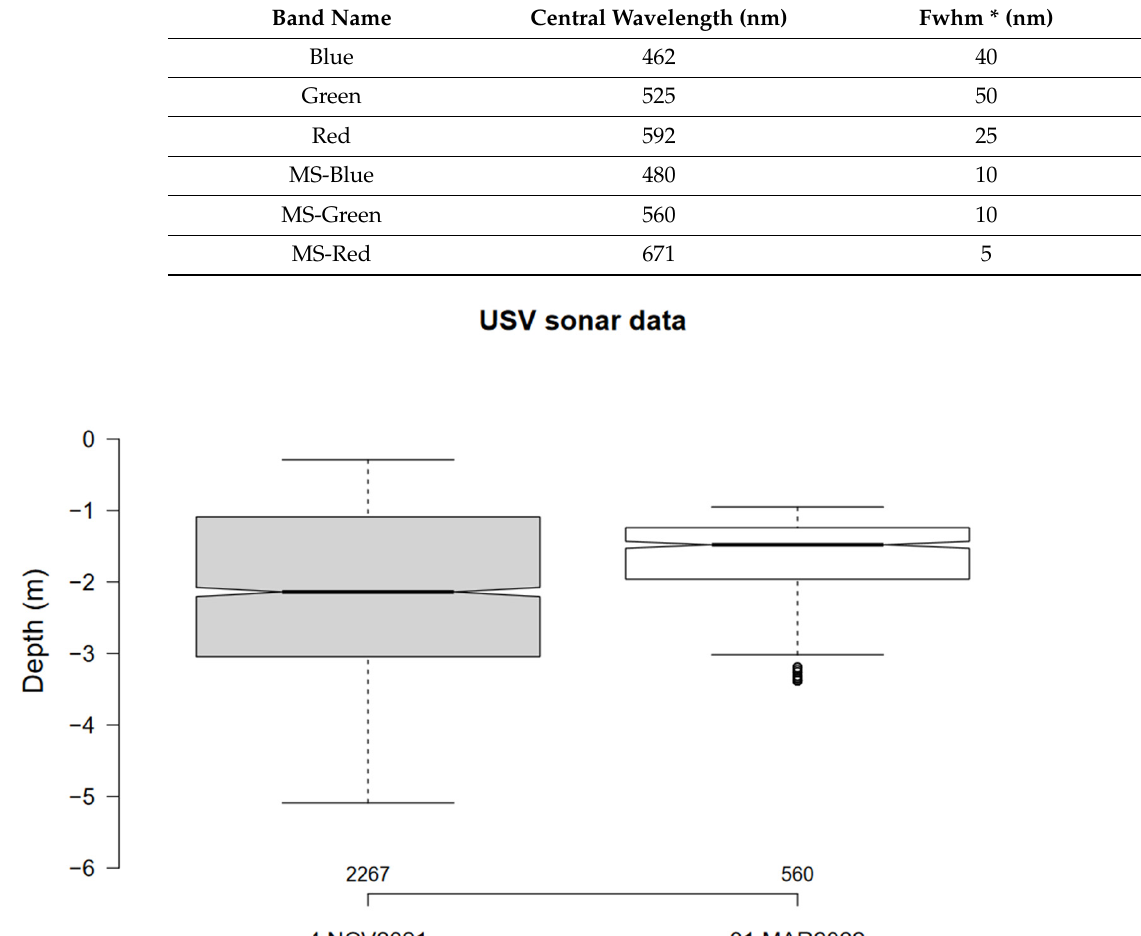
Table A1. Spectral characteristics of standard RGB and multispectral bands used for building the composite 6-band cube. * full width at half maximum.